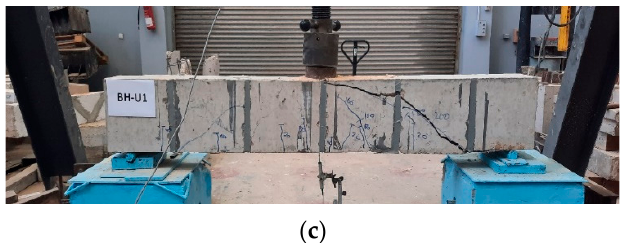
Figure 10. Failure modes of beams with one unaligned NSM ‐ CFRP strip: ( a ) BL ‐ U1, ( b ) BM ‐ U1, and ( c ) BH ‐ U1.